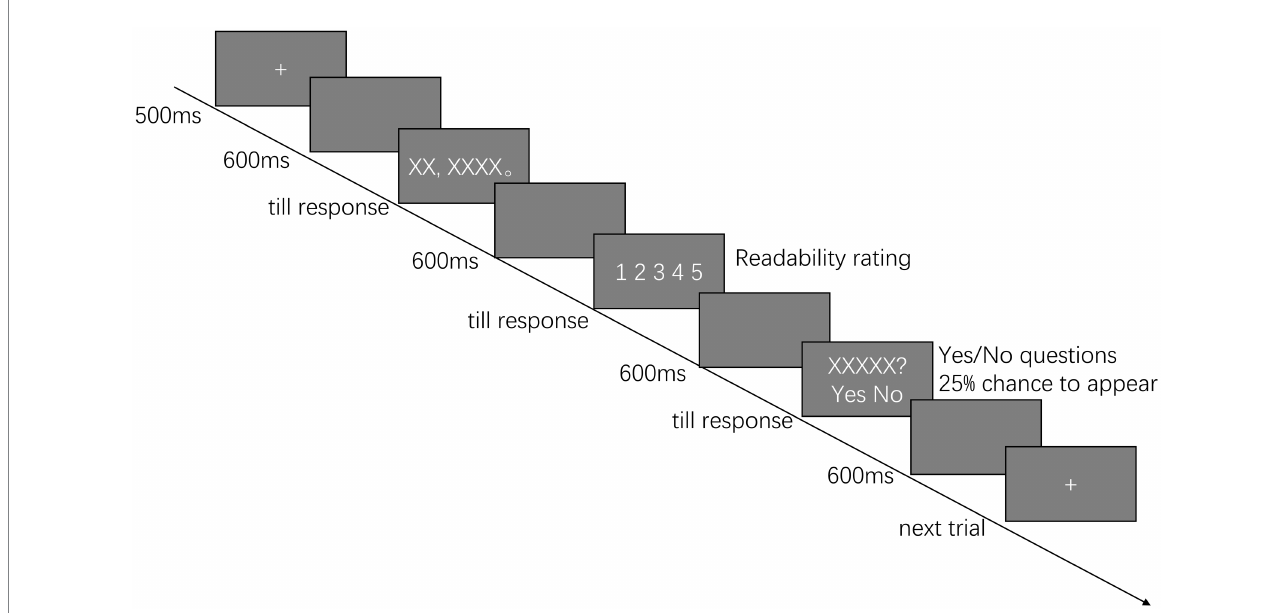
FIGURE 1 An illustration of the procedures of the eye-tracking